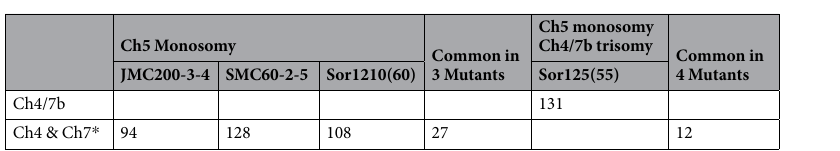
Ch5 monosomy Ch4/7b trisomy